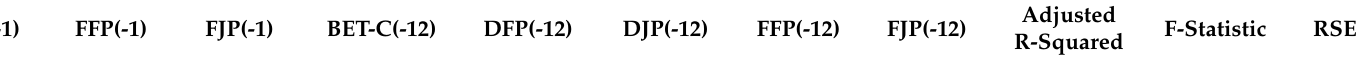
Table 5. Lagged relationships between stock returns and investors trading